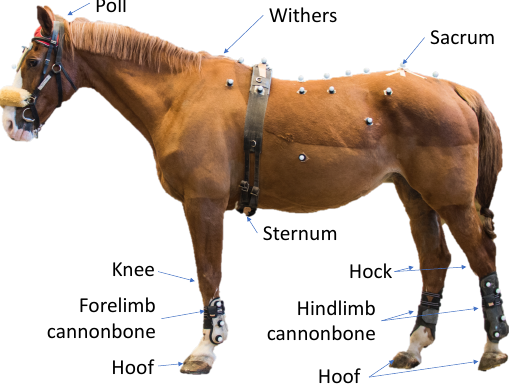
Figure 1. Relevant anatomical positions on a horse.